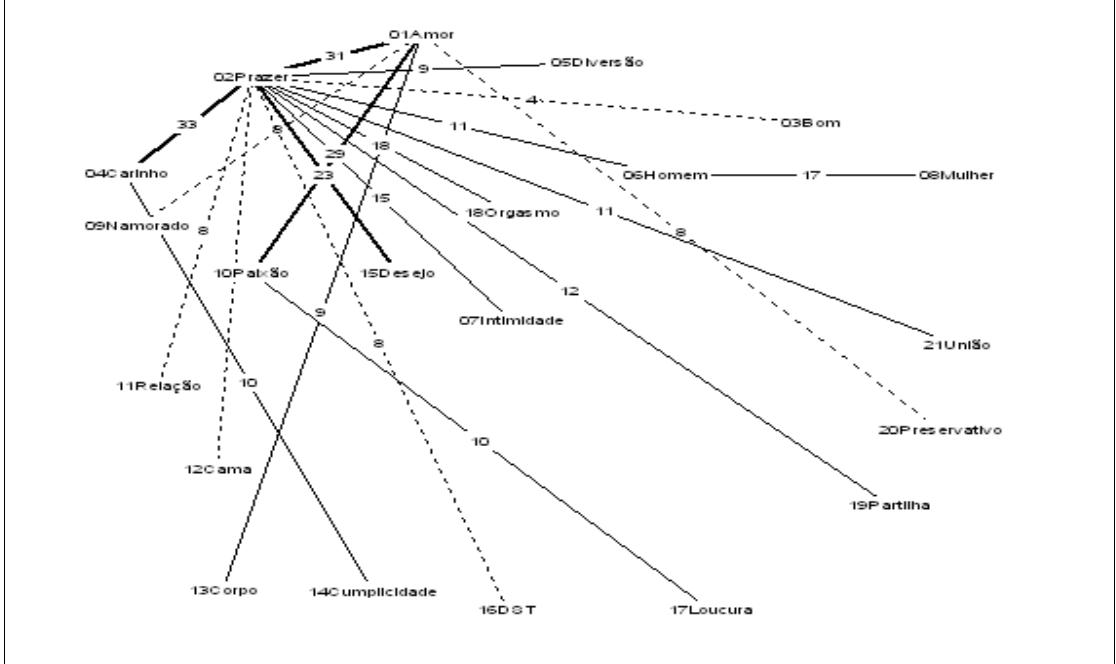
Figura 1 . Coocorrências das palavras